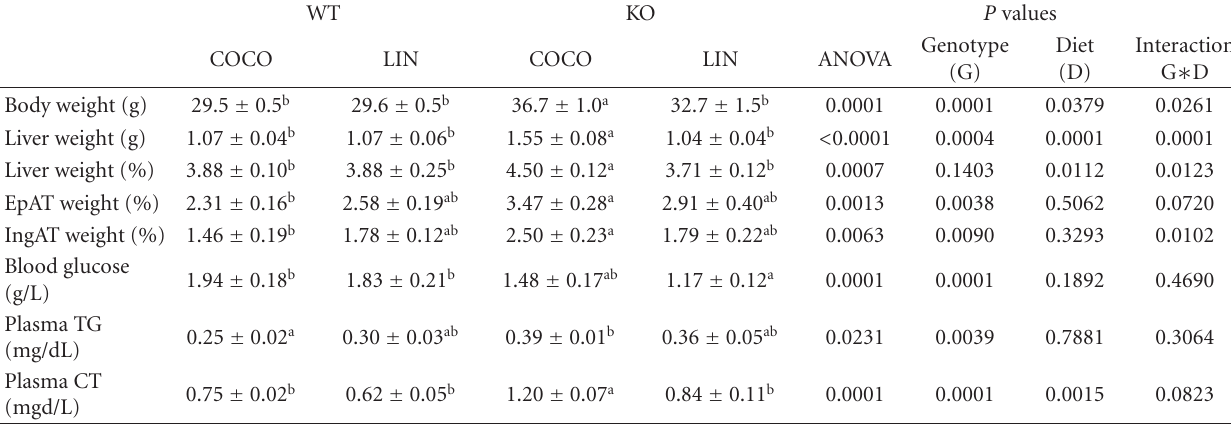
Table 2: Markers of PPAR α deficiency in WT and PPAR α -null (KO) mice fed diets containing either saturated FA (COCO diet) or ALA (LIN diet) for 8